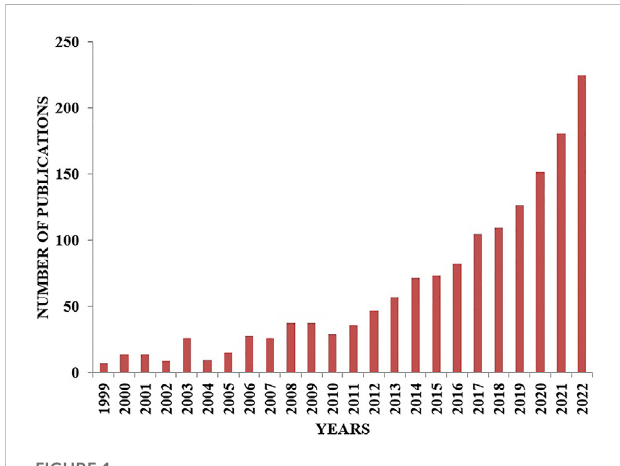
FIGURE 1 Papers published in science direct journal for phrase search “ bacterial concrete ” in the last two